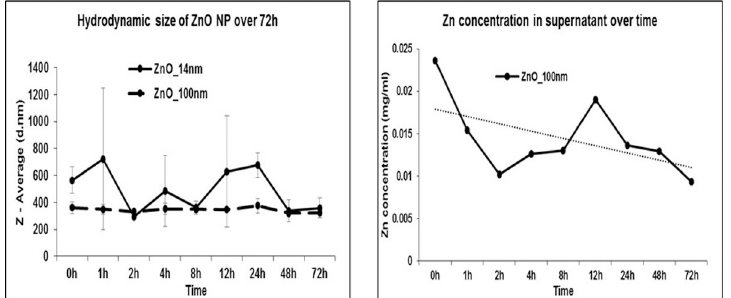
Fig 3. A. Hydrodynamic size of ZnO NPs (14nm and 100 nm) monitored over 72h time course. B. Zinc concentration in supernatant monitored over 72h time course.